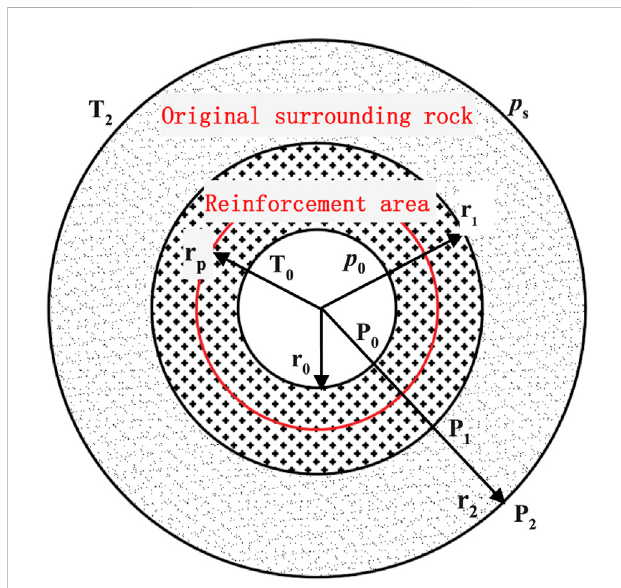
FIGURE 1 Mechanical model of surrounding rock reinforced by grouting in